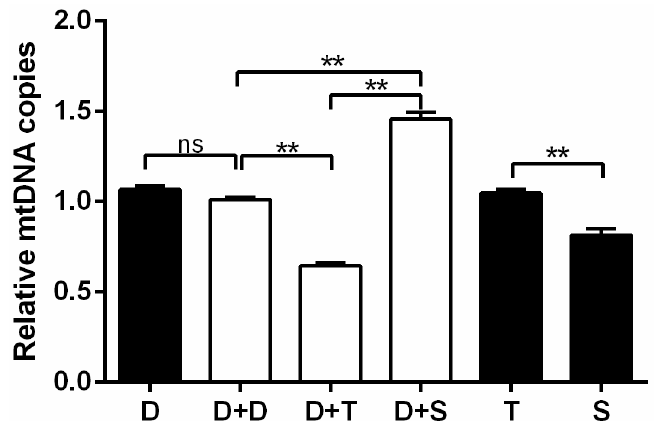
Figure 4. Measurement of relative mtDNA copies in primary cells and cybrids. Black column, DF-1 cells and primary cells; white columns denote cybrids. n = 3 per group. ** means p < 0.01 and ns means p > 0.05.